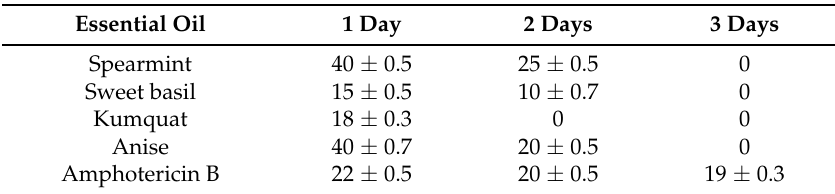
Table 4. Antifungal activity of the essential oils and amphotericin B as positive control against Aspergillus niger monitored by the disk diffusion